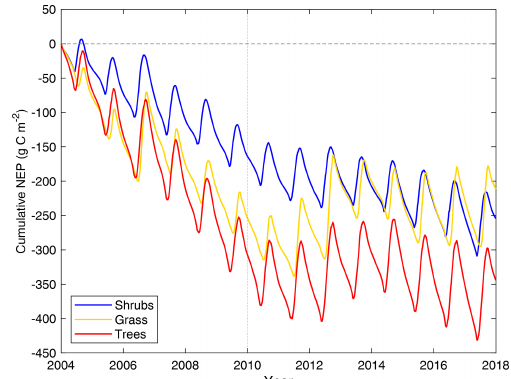
Figure 7. Cumulative daily modelled net ecosystem productivity (NEP) for 2004–2017 for the shrub, grass, and tree simulations. Negative values indicate the land surface was releasing CO 2 into the atmosphere. The vertical dotted line indicates the year marking a shift in weather, with colder and drier weather before 2010 and warmer and wetter weather